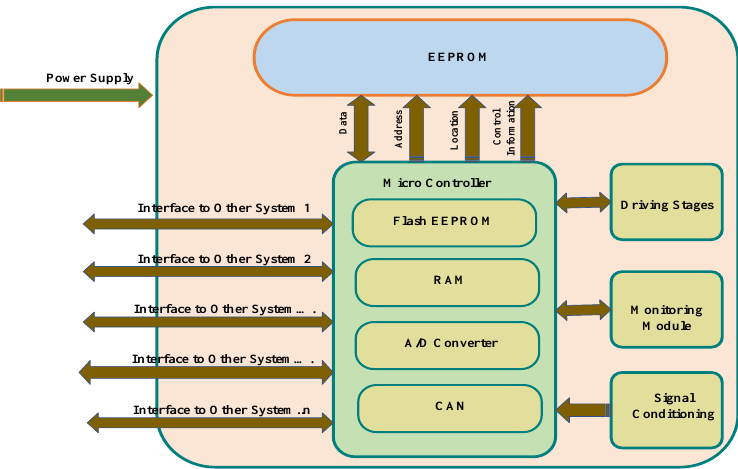
Figure 2. Internal Configuration of ECUs.